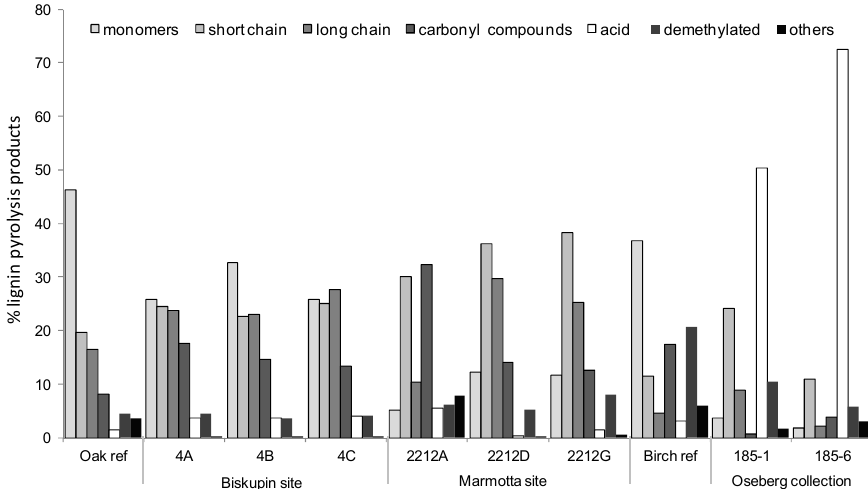
Figure 8. Abundances of the categories of lignin pyrolysis products expressed as percentages in the archaeological and the reference wood samples. The relative standard deviation obtained by Py-GC/MS of lignocellulosic materials is about 7%, as reported in the literature [7,30]. In terms of the detailed information that can be provided by Py(HMDS)-GC/MS, spe- cific degradation products can be identified and related to specific degradation pathways.